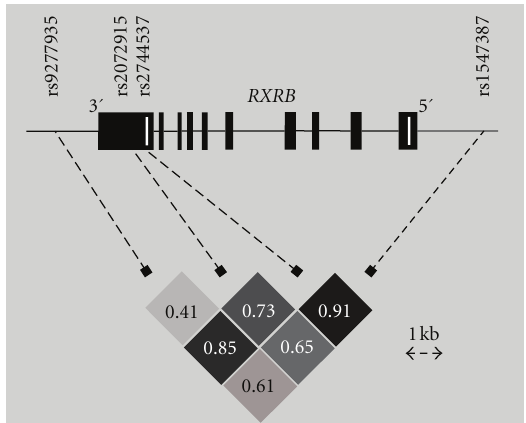
Figure 1: Location of the four tagging SNPs of the RXRB gene and LD structure. The LD is plotted as D (cid:3) and intensity coded (darker shades corresponding to higher degree of LD). The RXRB gene is transcribed from centromer to telomer, that is, from right to left. RXRB exons are depicted as black boxes, and translation start and stop points are marked by white vertical